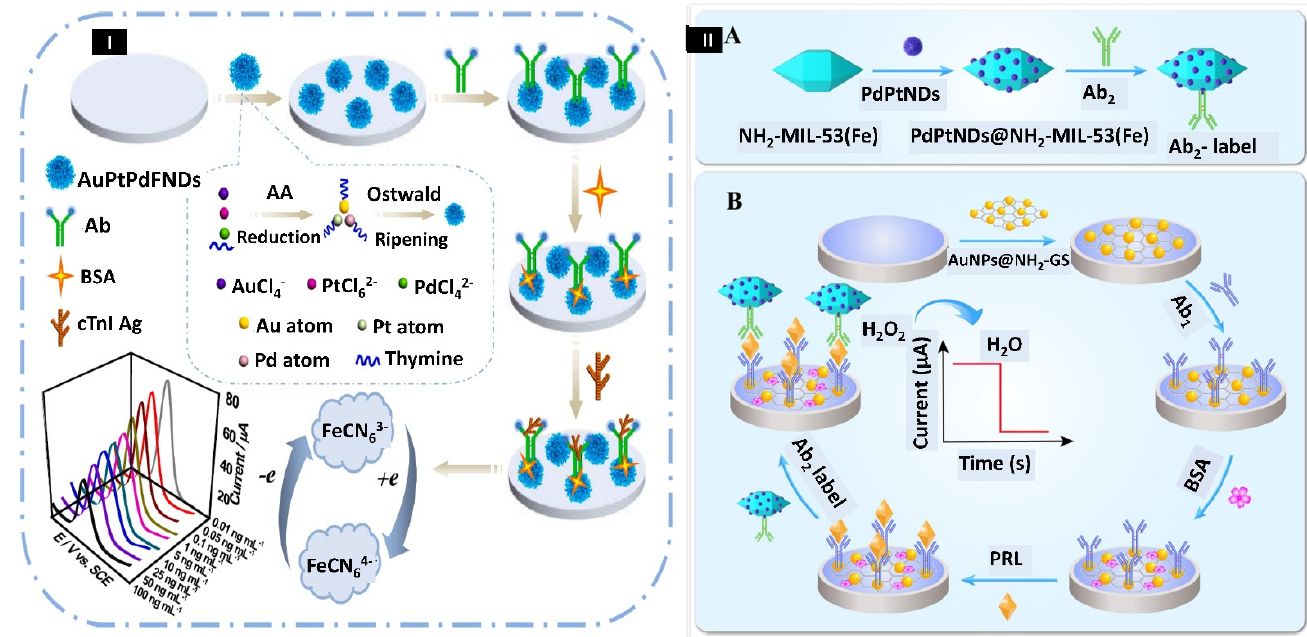
Figure 4. ( I ) Pictorial representation of AuPtPd trimetallic fluffy-like nanodendrites (FNDs)-based sensor for identification of cardiac troponin I (cTnI). Reprinted with permission from [126].